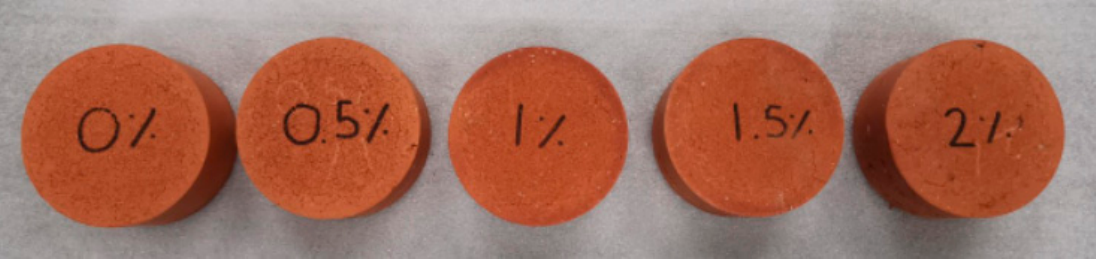
Figure 1. Some of the prepared brick samples with different percentages of cigarette butts (CBs).